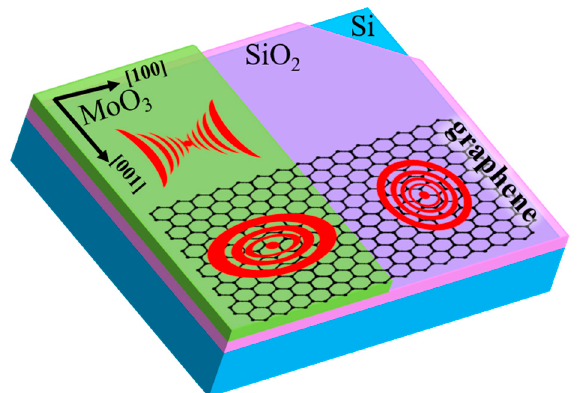
Figure 3. Schematic of the polariton hybridization in graphene/ α -MoO 3 heterostructure. The dispersion of graphene plasmons are governed by a frequency ( ω )—momentum ( q ) relation given by [23]: